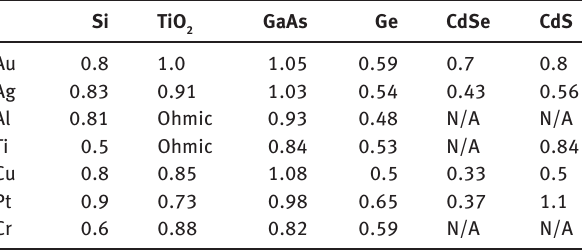
Table 1: Experimentally reported Schottky barrier heights φ for typical plasmonic materials on n-type semiconductors. Data adapted from Refs. [44, 47, 58–65]. For p-type semiconductors, the barrier height can be estimated by subtracting the value from the bandgap energy of the